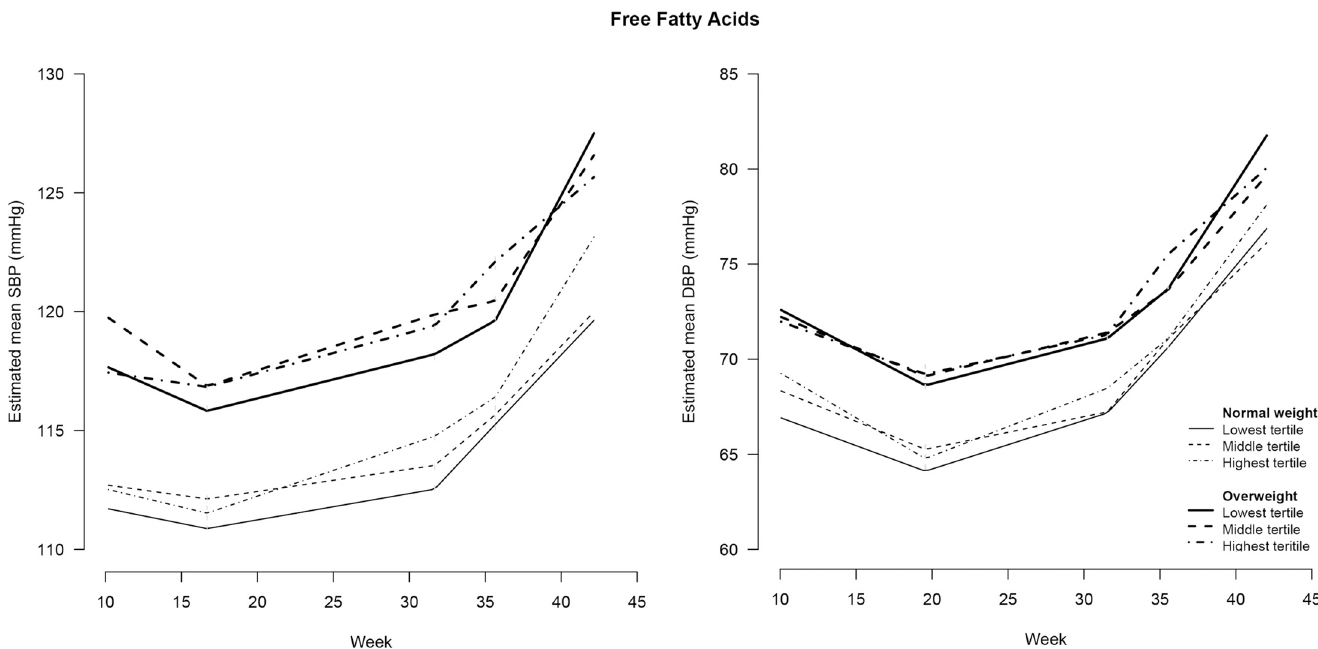
Fig 4. Blood pressure during pregnancy stratified for maternal weight status and tertiles of free fatty acids # . SBP = systolic blood pressure; DBP = diastolicblood pressure. # free fatty acids were determinedin non-fasting blood samples drawn at a medianof 13 (IQR = 12–14)weeks of gestation.